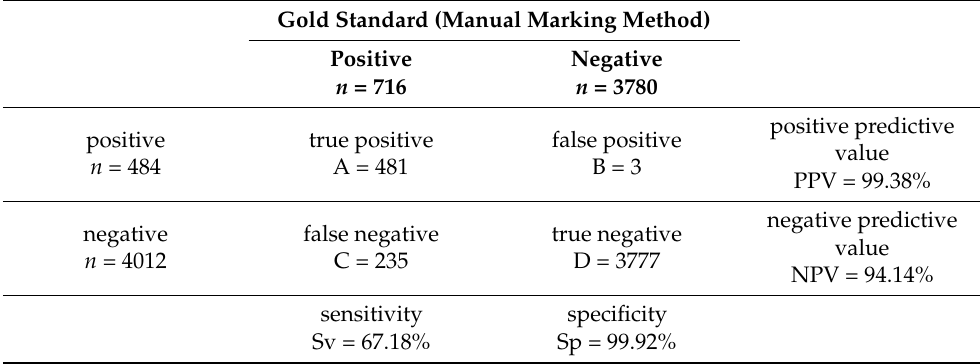
Table 1. Basic information and monitoring information of 4 patients.